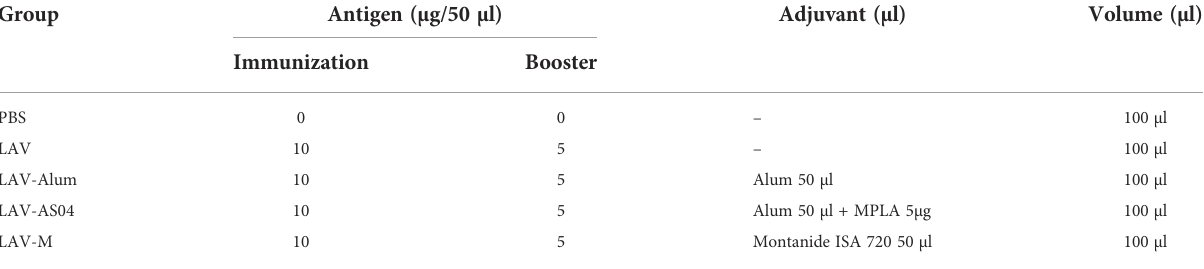
TABLE 1 Vaccine formulation and immunization schedule.